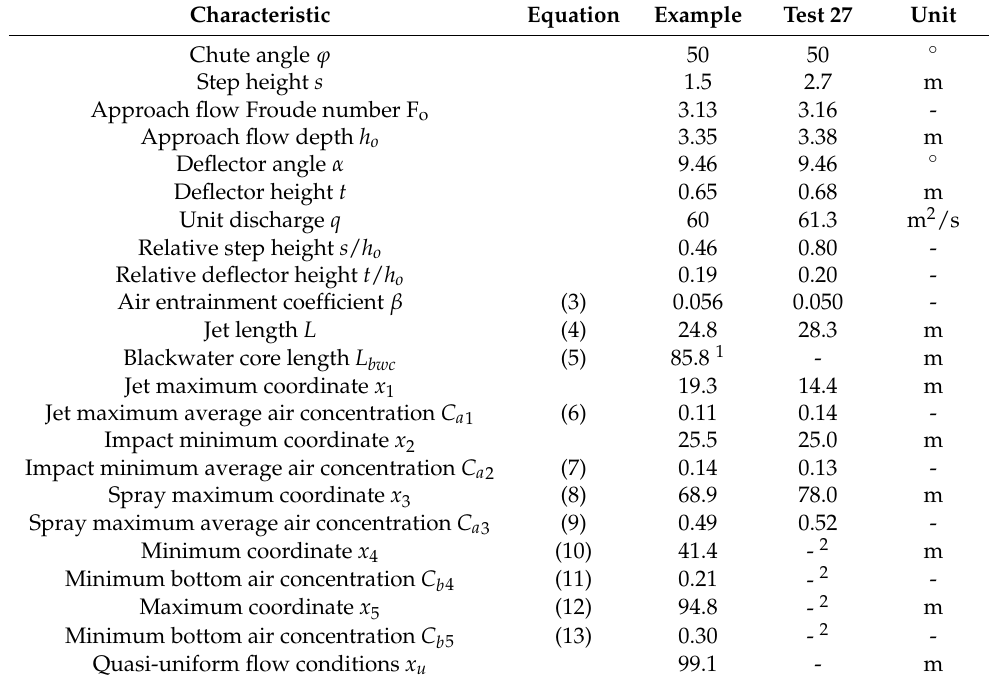
Table 3. Design example characteristics compared to test 27 using a scale factor λ =